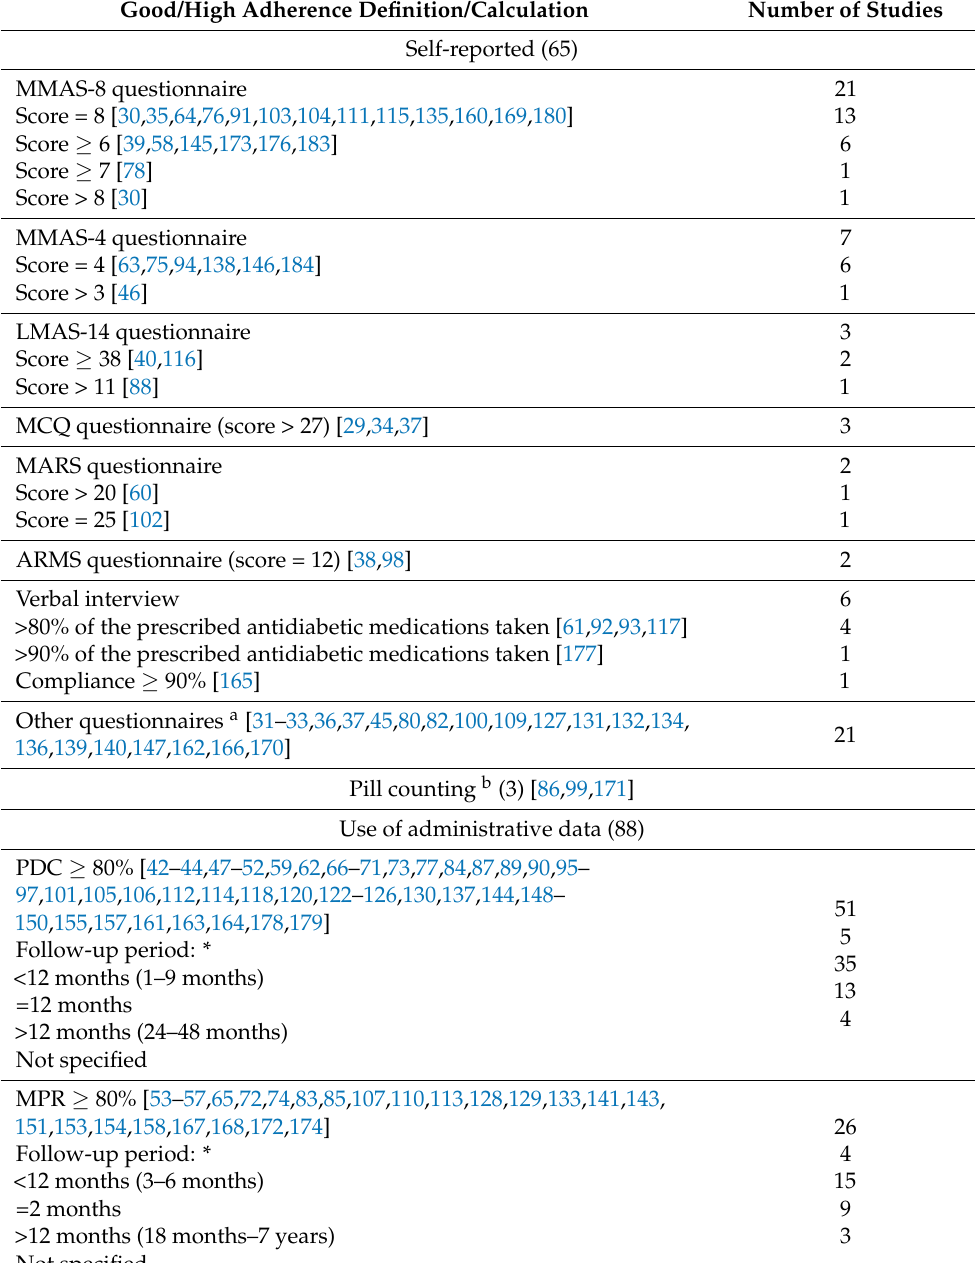
Table 1. Details of adherence calculation methods. List of abbreviations: MMAS-8: eight-item Morisky Medication Adherence Scale; MMAS-4: four-item Morisky Medication Adherence Scale; LMAS-14: Lebanese Medication Adherence Scale; MCQ: Medication Compliance Questionnaire